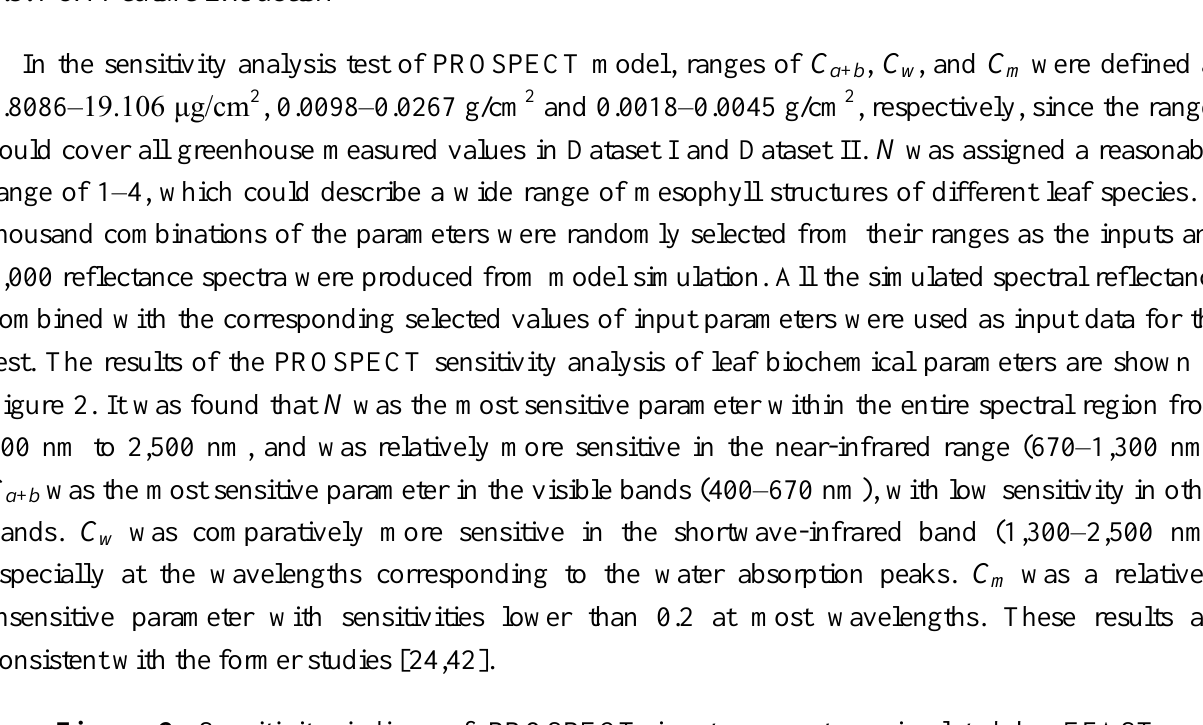
Figure 2. Sensitivity indices of PROSPECT input parameters simulated by EFAST (Extended Fourier Amplitude Sensitivity Test) method. (a) 400–1,000 nm, (b) 1,000–2,500 nm. FOSI: First Order Sensitivity Index, TSI: Total Sensitivity Index. The spectral positions of these selected bands (479, 508, 654, 673, 750 nm) are marked with vertical dotted